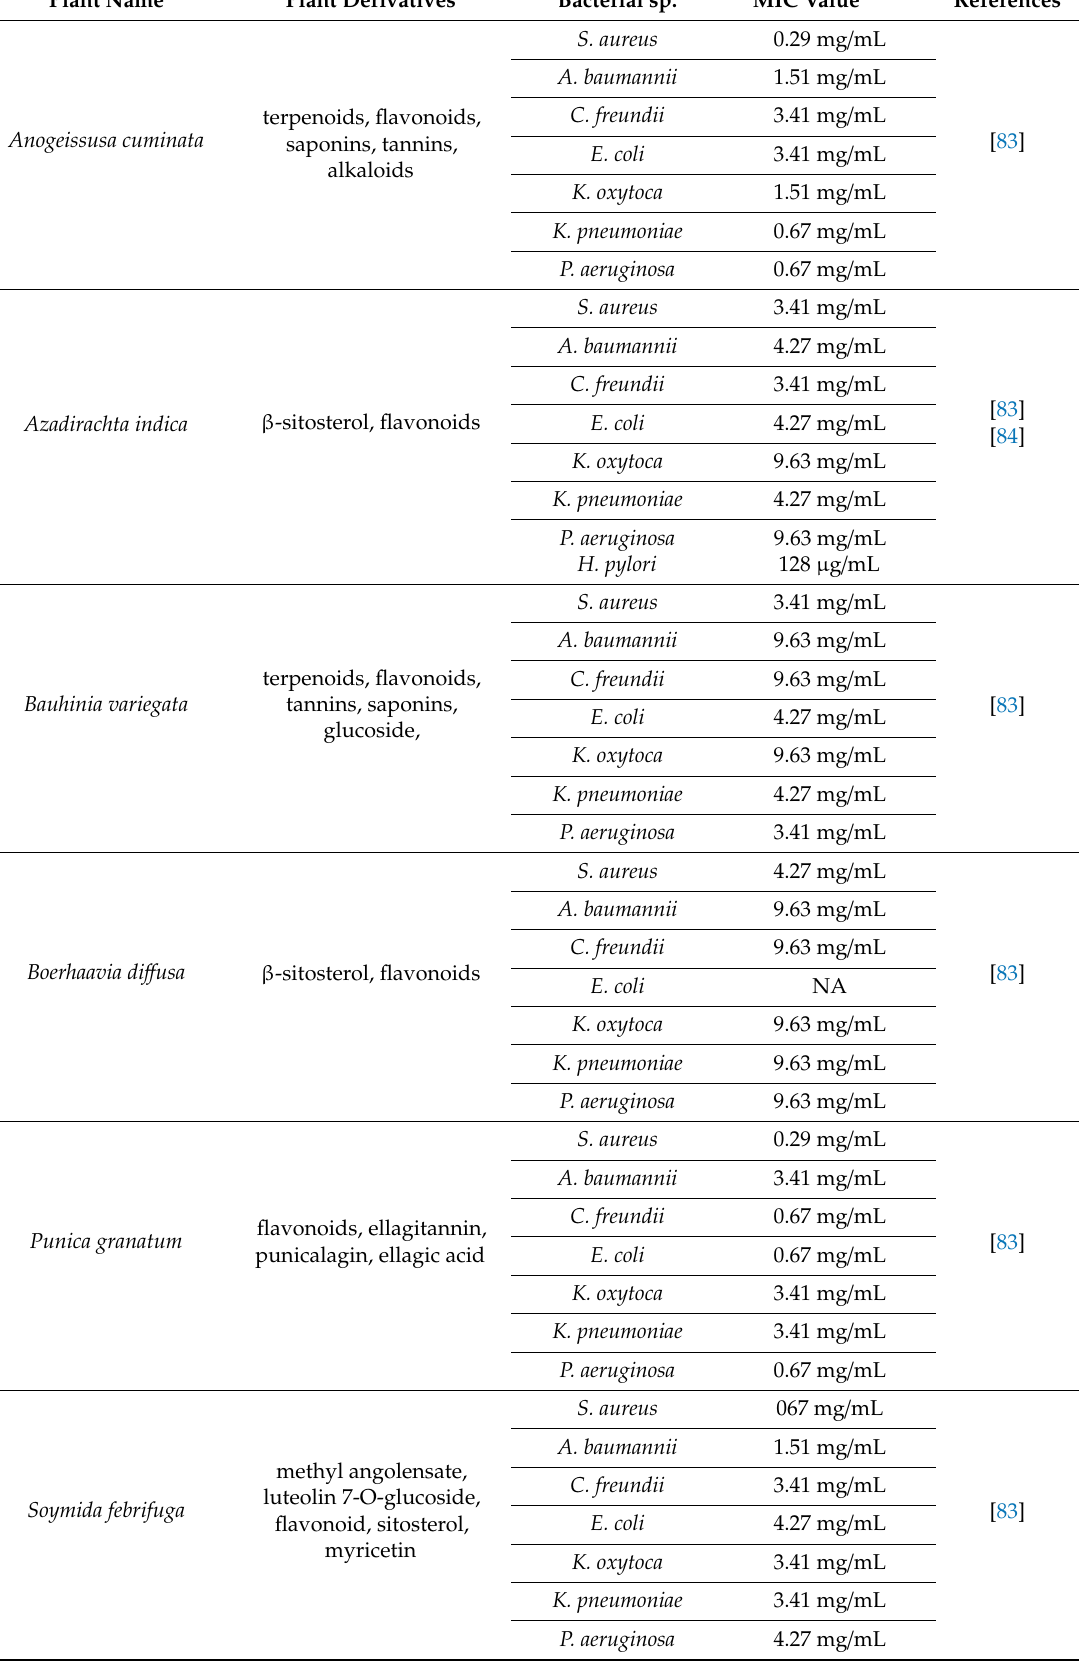
Table 1. Plant-derived substances and their action against di ff erent